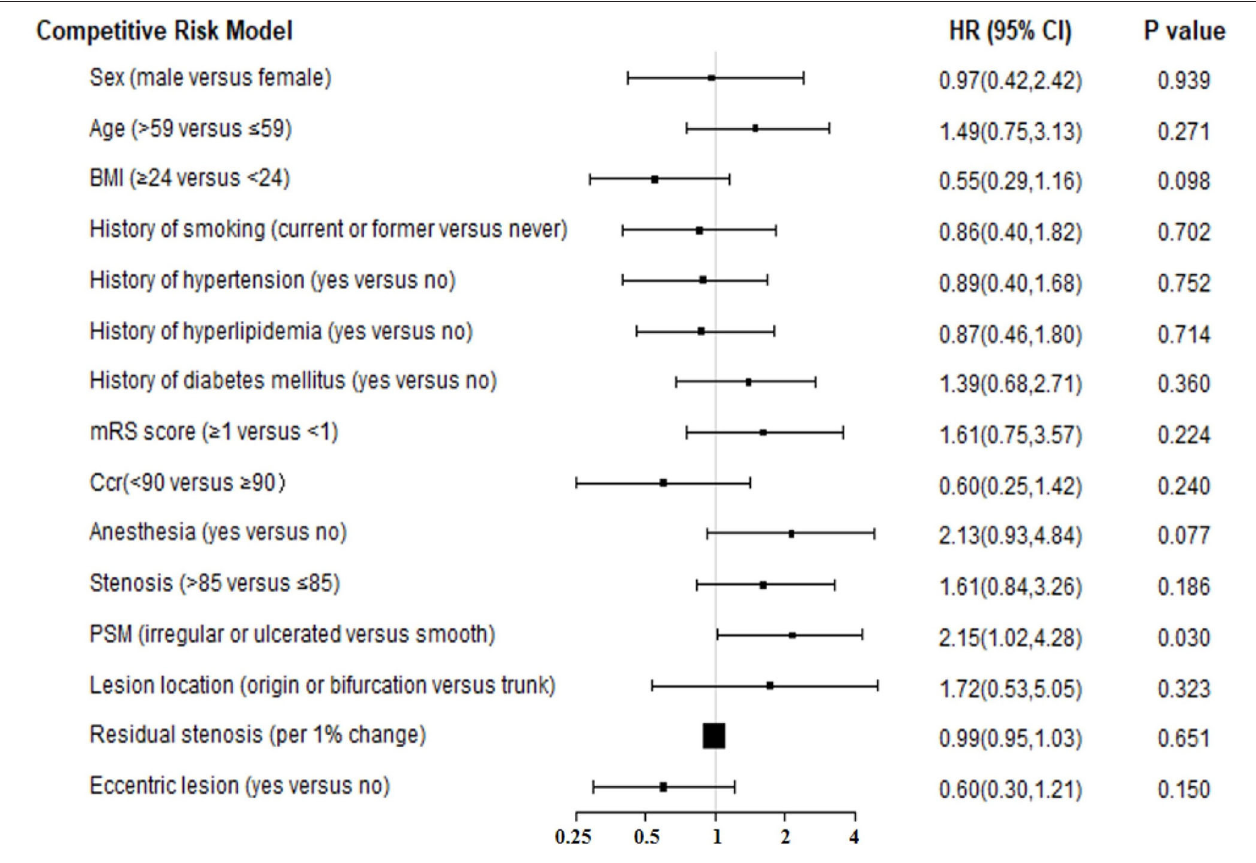
FIGURE 2 | The forest plot for results of competitive risk model for long-term outcome. BMI, body mass index; Ccr, creatinine clearance; PSM, plaque surface morphology; HR, hazard ratio; CI, confidence